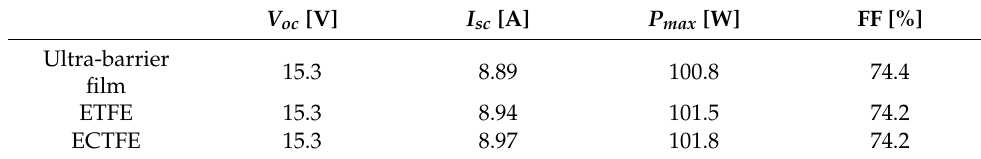
Table 3. Electrical output of 24-cell PV module for the different front-surface materials used.